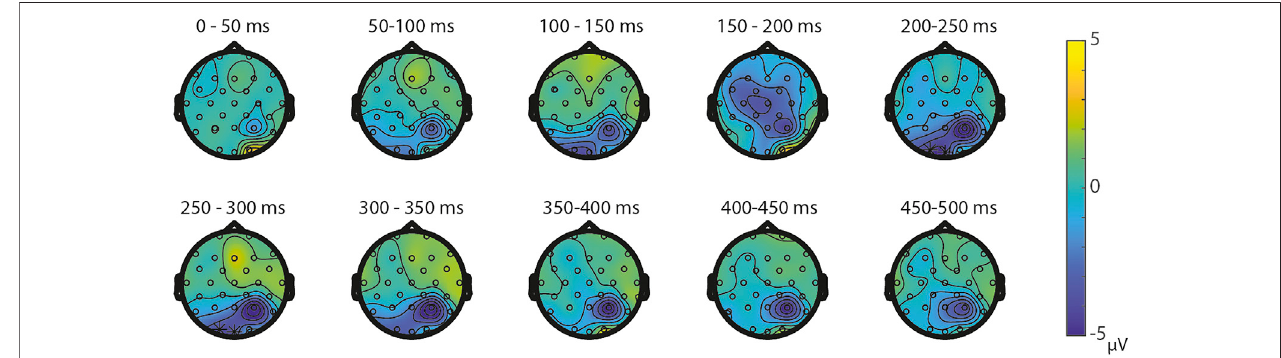
FIGURE 7 | Topoplots of the differences between small and large diameter per time window with asterisks representing the signi fi cant differences between the small and large diameter based on α (cid:1) 0.05.